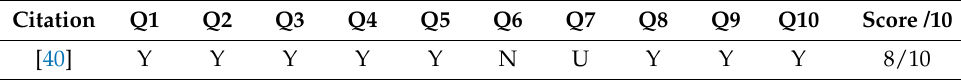
Table 2. JBI Critical Appraisal Checklist for Qualitative